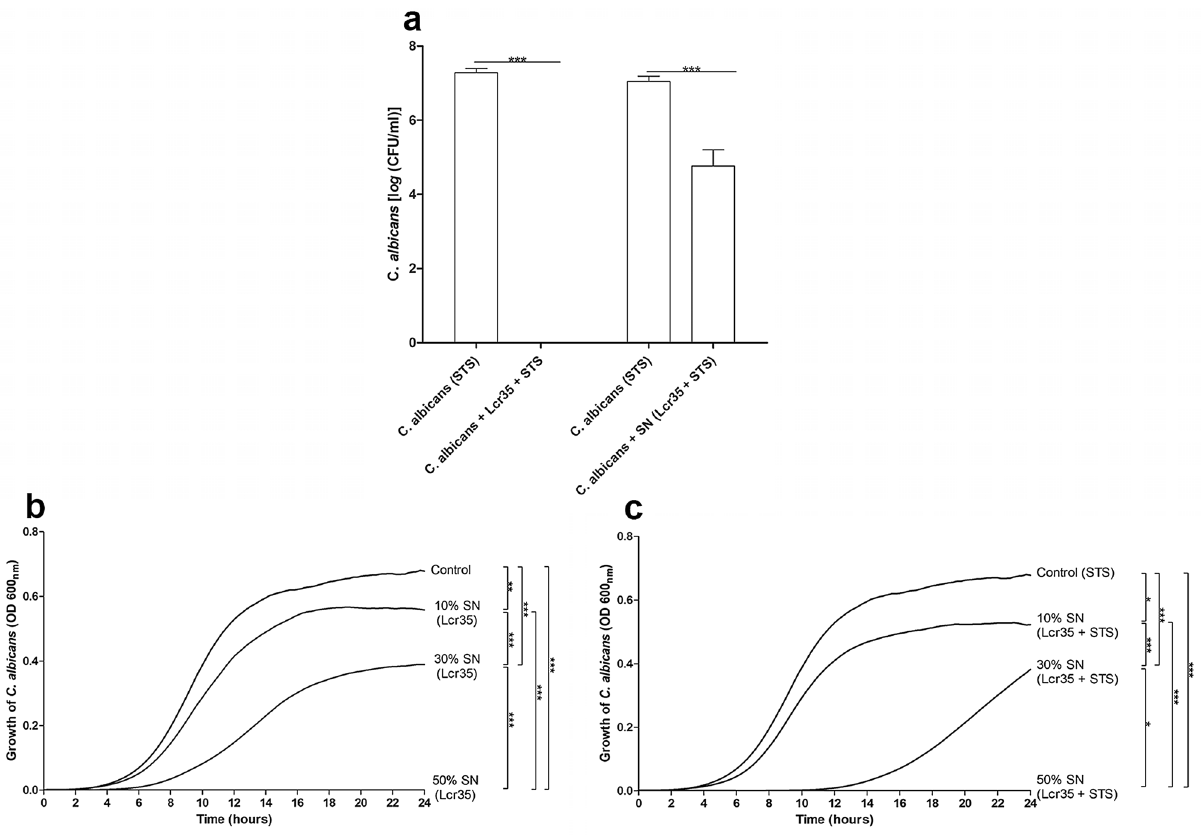
Figure 4. The impairment of viability and growth of C. albicans by Lcr35 is contact independent. The proximity-dependent mechanism of Lcr35 was tested using cell culture inserts ( a ). The microorganisms were cultivated with 0.4 µm-pore-size membrane to separate cells with Lcr35 in the bottom chamber and Candida albicans in the top chamber. Anti- Candida effect of Lcr35 cell free supernatant was evaluated on C. albicans viability at 37 °C over 48 h ( a ). The impact of cell free supernatant on C. albicans growth was evaluated during 24 h after inoculation in medium with Lcr35 supernatant ( b ) or Lcr35 + STS cell free supernatant ( c ). The